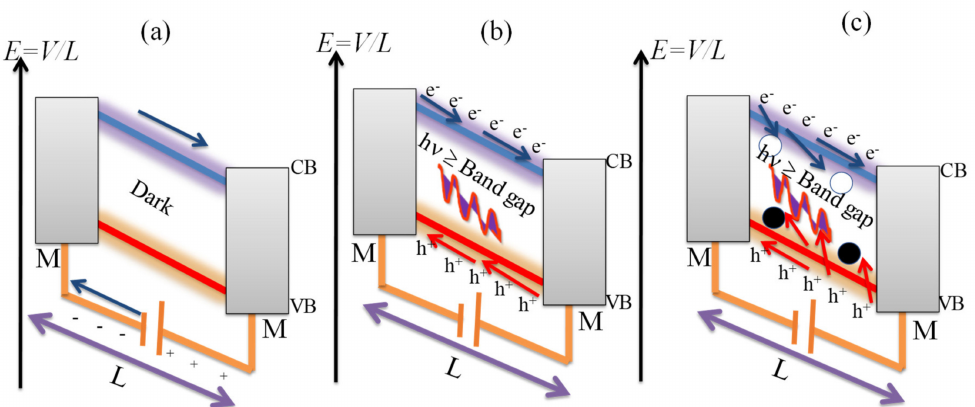
Figure 2. Schematic of a photoconductor between two metal contacts (M) ( a ) without illumination and ( b ) with illumination, ( c ) Schematic illustrating a photo-gating e ff ect between a semiconductor and two Ohmic metal contacts (M) under illumination. The open and closed circles are defect states that can capture a hole or an electron eventually modulating the resistance of the semiconductor. ( a , b ) are adapted with permission from reference